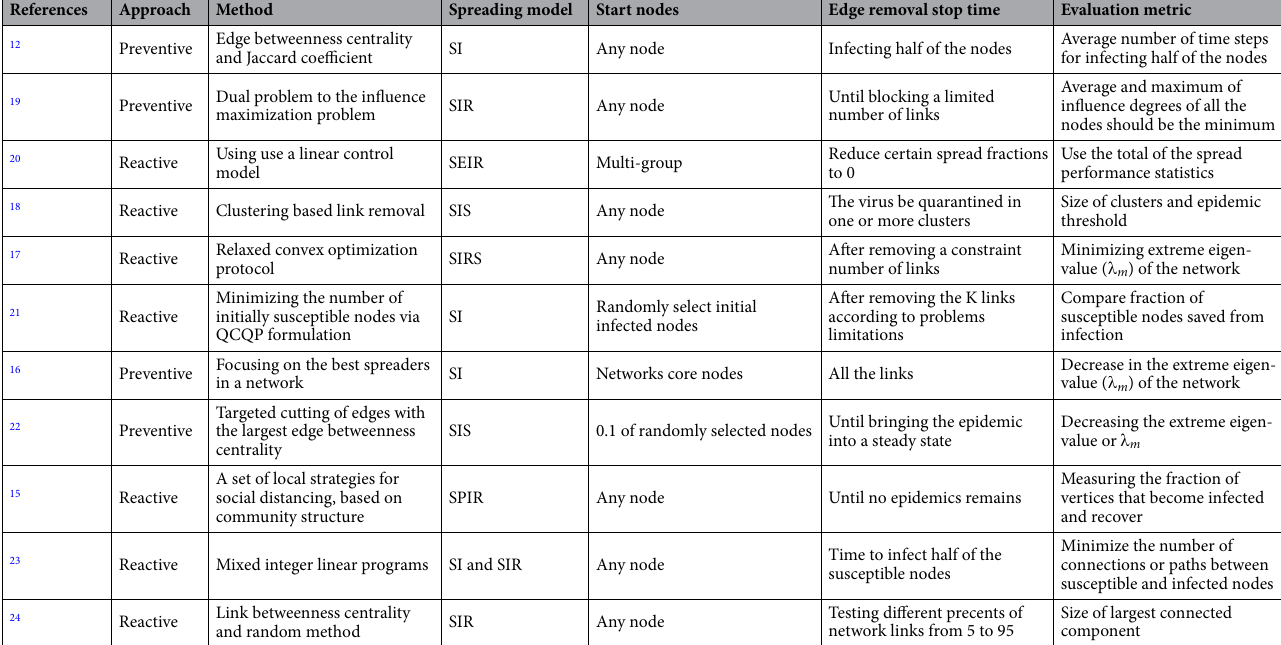
Table 2. Comparison of the edge removal based epidemic mitigation papers according to six important